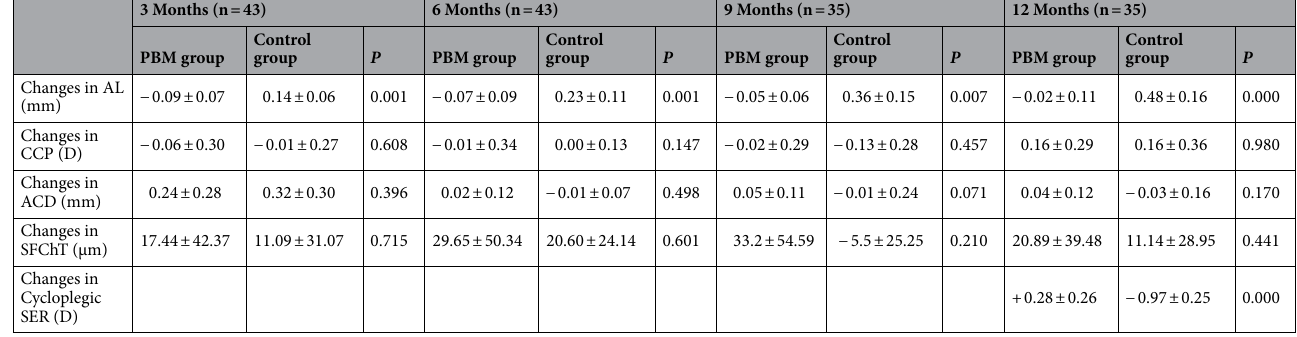
Table 2. Changes from baseline measurements in ocular parameters for the two groups. AL axial length, CCP central cornea power, ACD anterior chamber depth, SFChT subfoveal choroidal thickness, PBM group